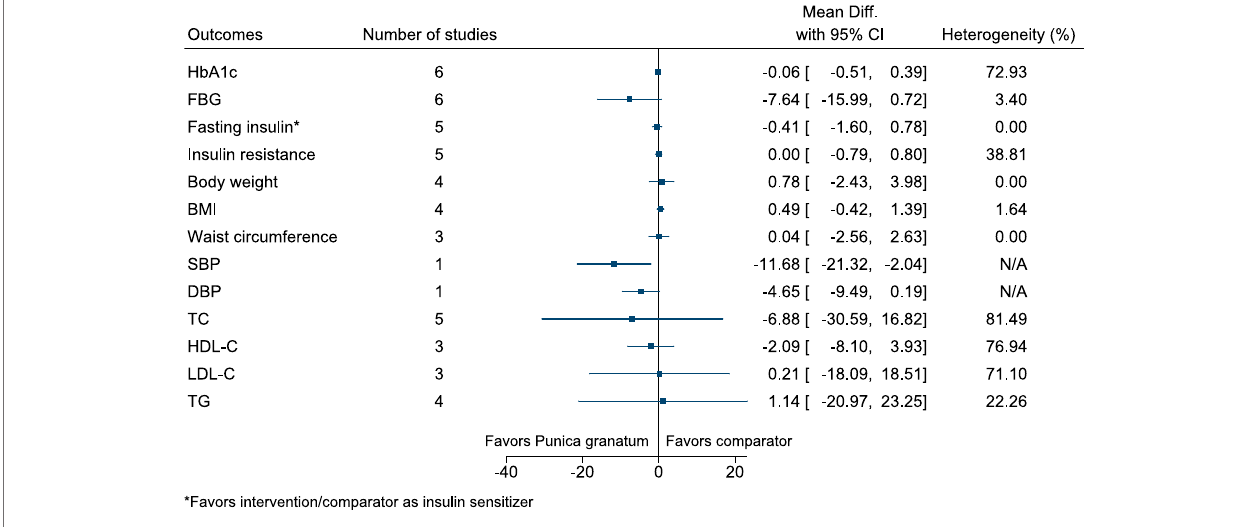
FIGURE 28 | Punica granatum — Summary forest plot.